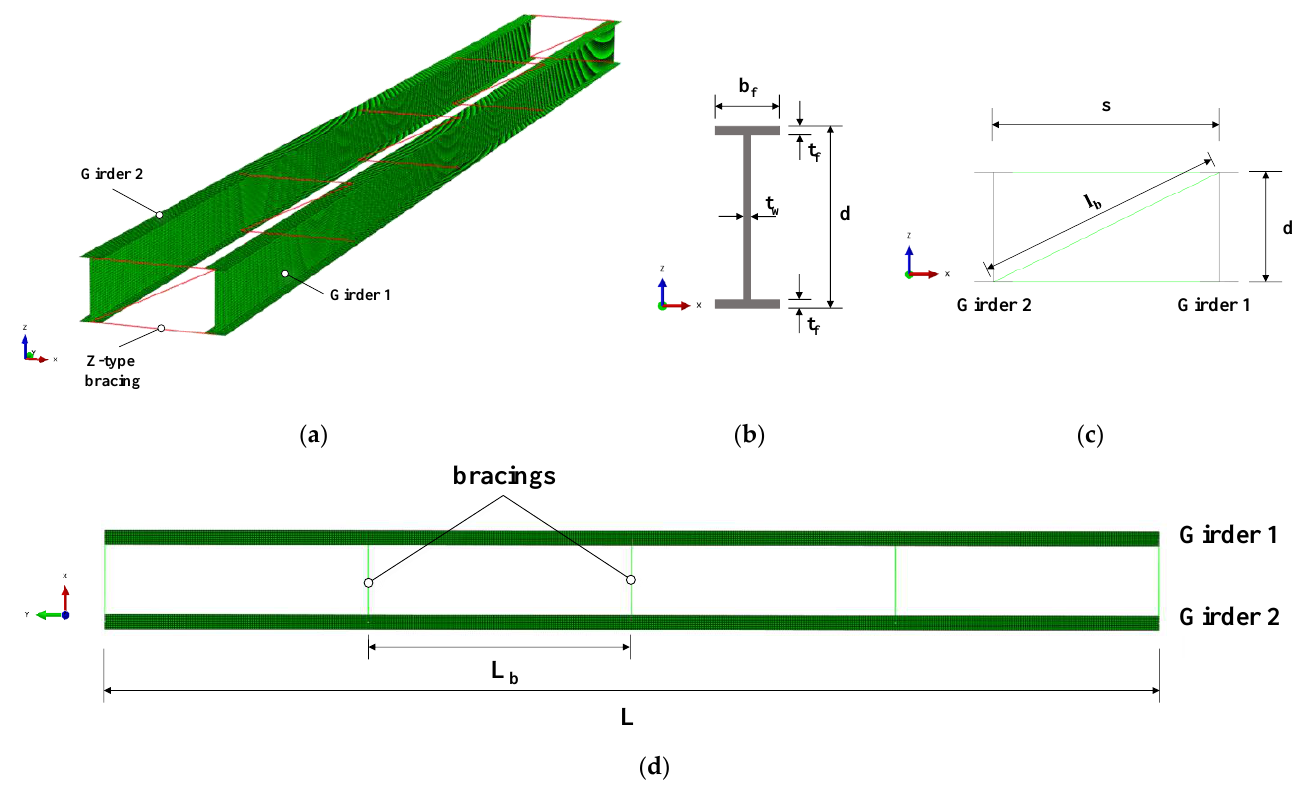
Figure 1. FEA model used in this study: ( a ) FEA model; ( b ) cross-section of I-girder; ( c ) plane view of the bracing system; ( d ) top view of bracing system.